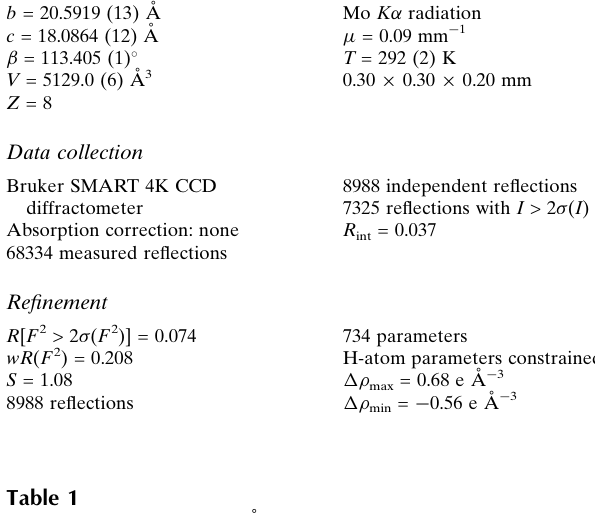
Hydrogen-bond geometry (A˚ , (cid:2)